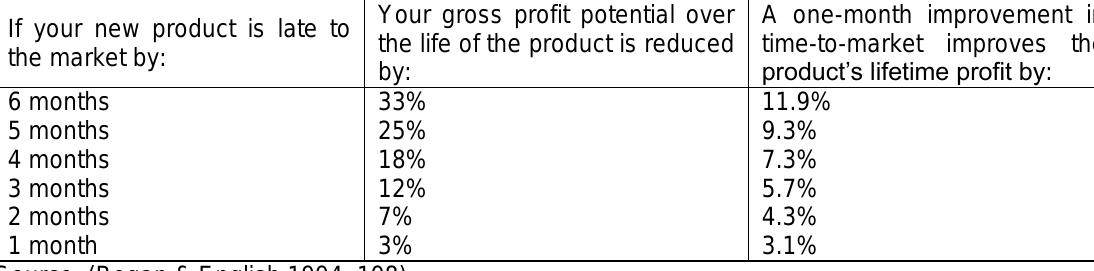
Table 1: The Cost of Being Late to the